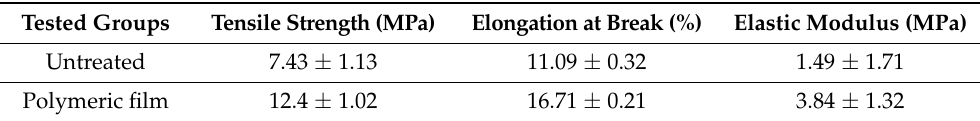
Table 4. Tensile strength of skin in various treatment groups.